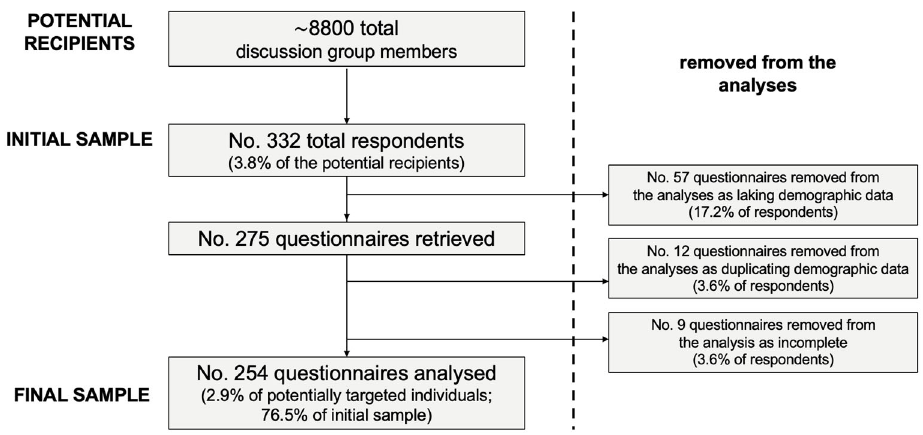
Figure 1. Flow chart of the selection of study participants. Briefly (Table 1), the majority of respondents were of female gender (53.5%),